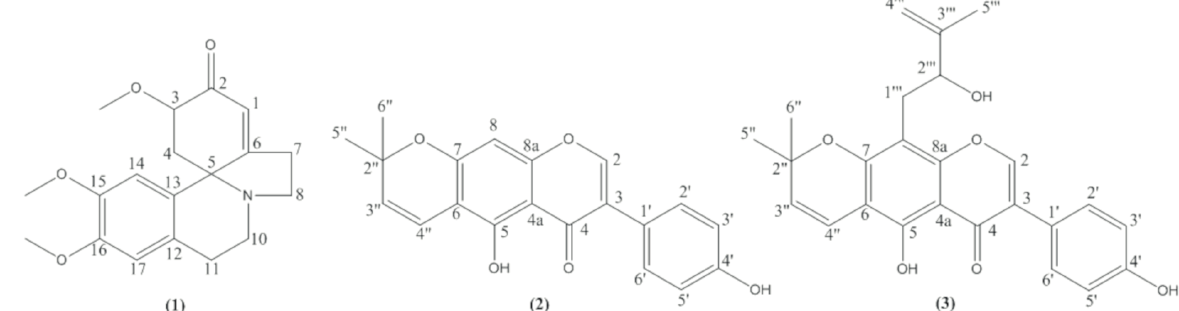
Figure 1. Chemical structures of compounds 1 (erythratidinone), 2 (alpinumisofl avone) and 3 (erysenegalensein